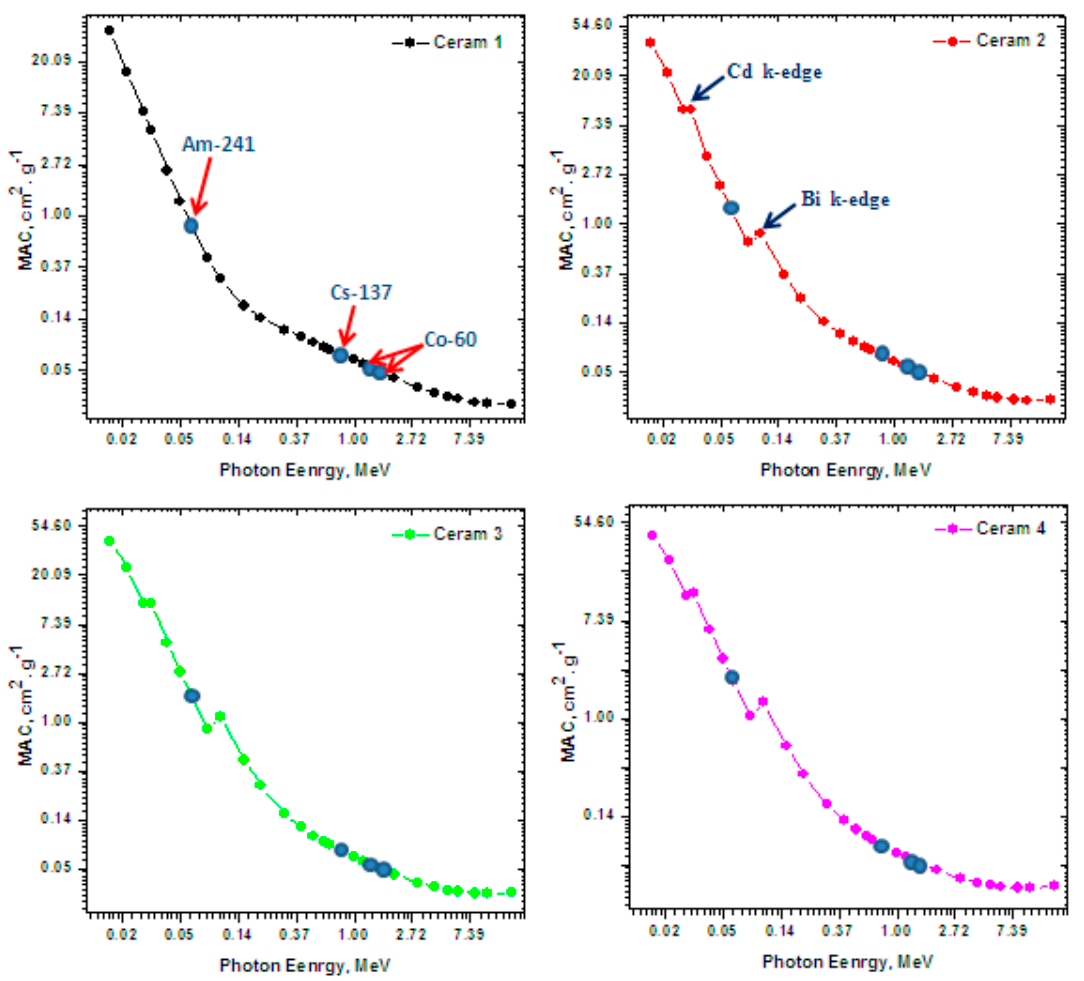
Figure 6. The mass attenuation coefficients (MAC) of the ceramic